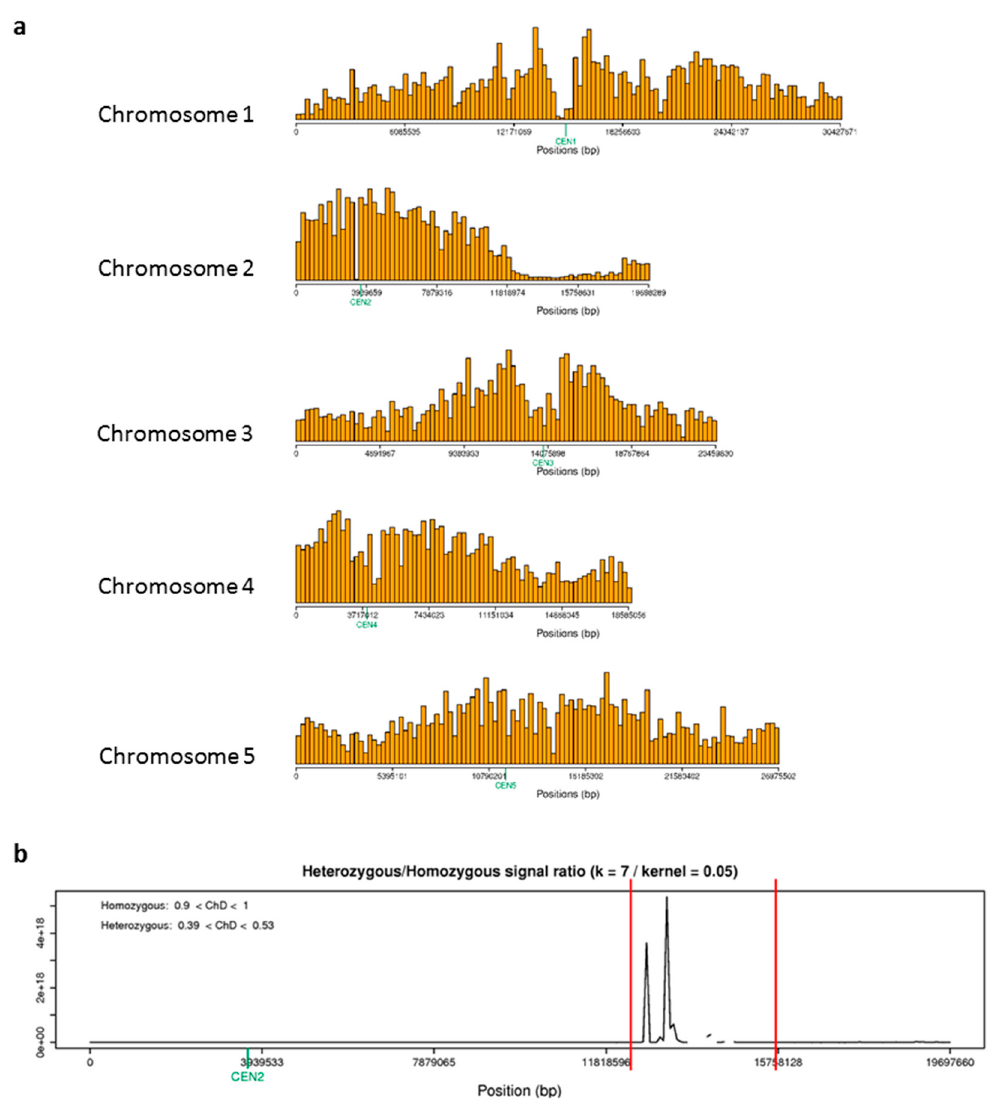
Figure 6. Fine mapping of asr2 locates it to a region of chromosome 2. Next-Generation Mapping (NGM) was applied to an asr2 mapping population by sequencing homozygous asr2 F 2 plants from an asr2 and Ler outcross, and processing SNPs that deviated from the Arabidopsis TAIR10 genome reference sequence through the NGM tool http://bar.utoronto.ca/ngm/ [25]. ( a ) The tool identified SNP desserts (depression on chromosome 2) corresponding to asr2 linkage. Shown are genome-wide SNP frequencies (y-axis) plotted as a function of chromosomal position (x-axis) using a bin size of 250 kb. ( b ) Closer inspection of chromosome 2 narrowed the asr2 locus to a 2,093,087 bp region indicated by peaks on the y-axis (ratio of homozygous to heterozygous signals) and bordered by two red